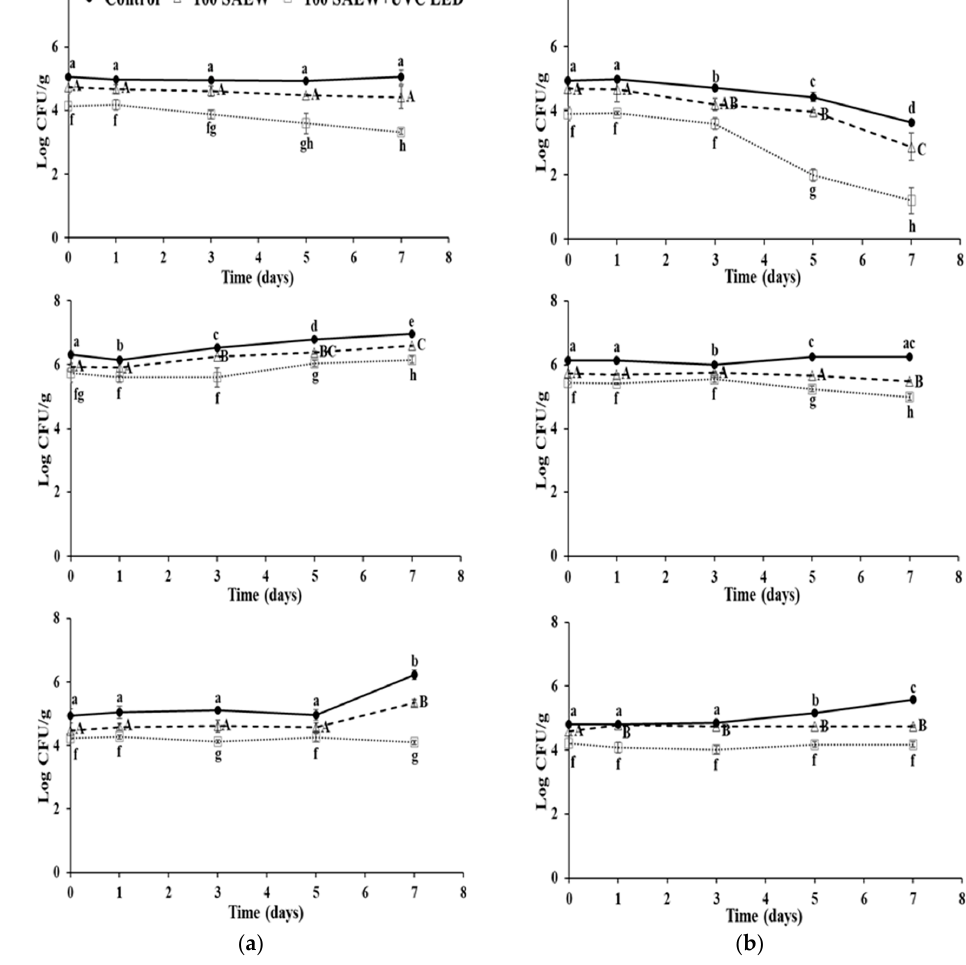
Figure 2. Log number of enterohemorrhagic E. coli (EHEC) ( a ) and S. aureus ( b ) after treatment in strawberry, baby leaves, and sliced onion stored for 7 days at 10 °C. ● , no extra wash with sanitizer (control); △ , aerosolization with 100 ppm SAEW (100 SAEW); □ , aerosolization with 100 ppm SAEW and UVC LED irradiation with 275 nm (100 SAEW + UVC LED). a–e; A–C; f–h Different letters within each treatment represent significant differences by Duncan’s multiple tests at p < 0.05.